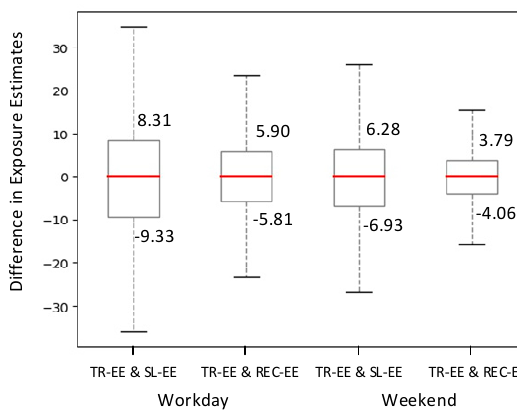
Figure 10. Box plots of the differences in each pair of exposure estimates on a workday and a weekend.